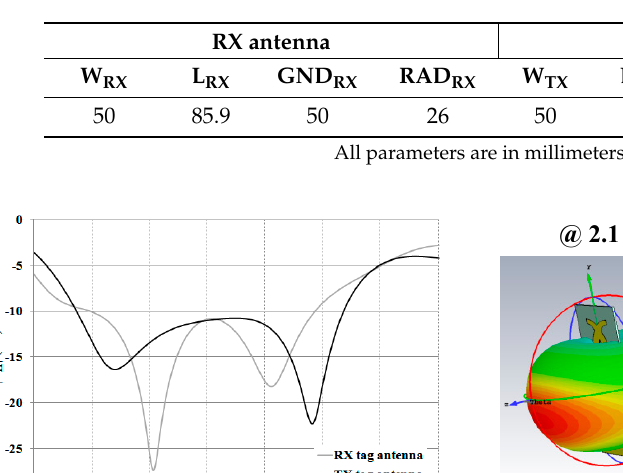
Figure 5. Geometries and dimensions of the wideband antennas proposed as RX tag antenna ( a ) and TX tag antenna ( b ). Table 1. Dimensions of the antennas illustrated in Figure 5. Table 1. Dimensions of the antennas illustrated in Figure 5.